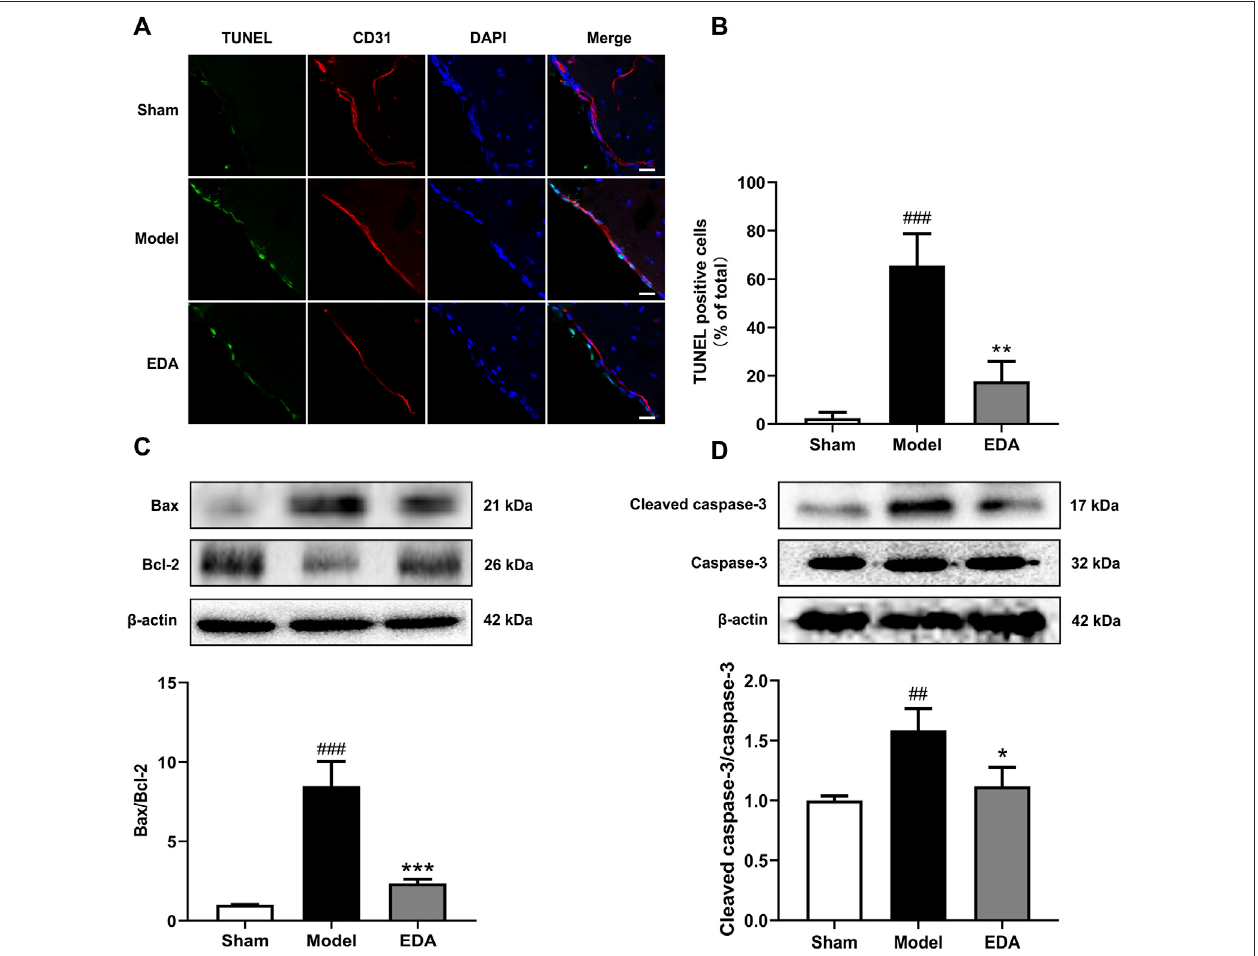
FIGURE 7 | EDA mitigates cerebral endothelial apoptosis stimulated by MCAO/R in mice. (A) Brain-frozen sections were stained with TUNEL (green) and CD31 wasusedasamarkerforendothelialcells;thenucleiwerestainedwithDAPI(blue)(scalebar=20 μ m). (B) Quantitativeanalysesofapoptoticcellsinendothelialcells. (C) Western blot analysis for the expression of Bax and Bcl-2 in brain tissues. (D) Western blot analysis for the expression of cleaved caspase-3 in brain tissues. All data are presented as the means ± SEM, n = 6. # p < .05, ## p < .01, ### p < .001, vs. Sham group, * p < .05, ** p < .01, *** p < .001, vs. MCAO/R group.